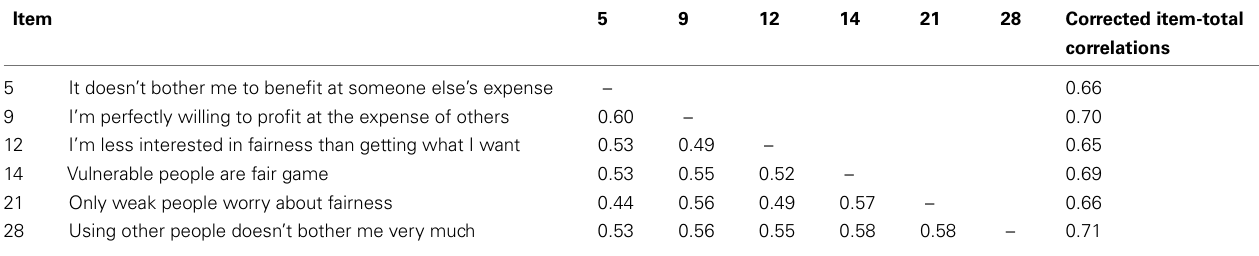
Table 3 |The Interpersonal Exploitativeness Scale: inter-item and corrected item-total correlations (Study